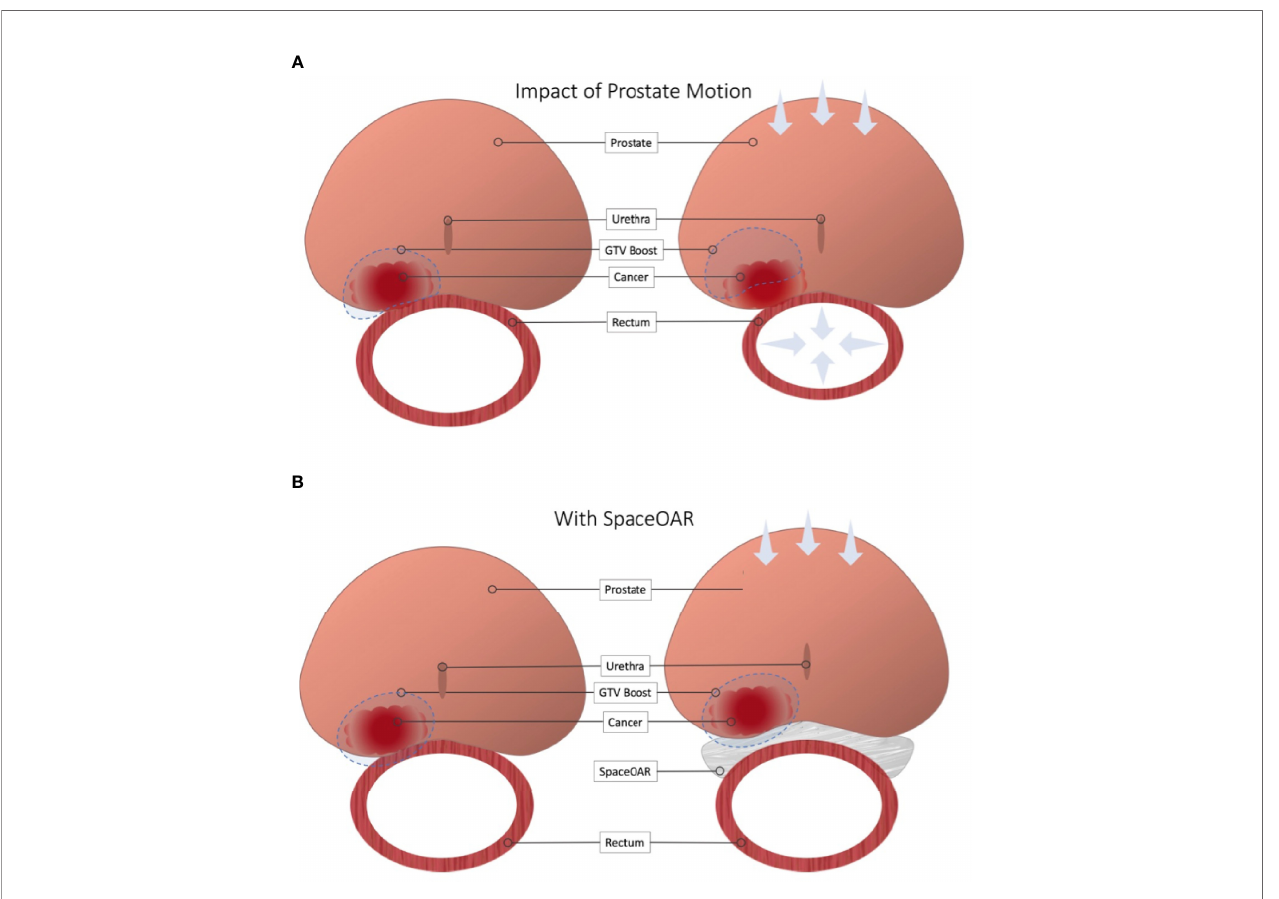
FIGURE 3 | Impact of Rectal Spacer in Focal Dose Escalation. (A) Close proximity to the rectal wall can necessitate compromises in order to meet OAR constraints. Furthermore, minimal or omitted boost margins mean slight changes in local anatomy can cause a geographic miss. (B) Placement of a rectal spacer allows for greater boost margins and safer dose